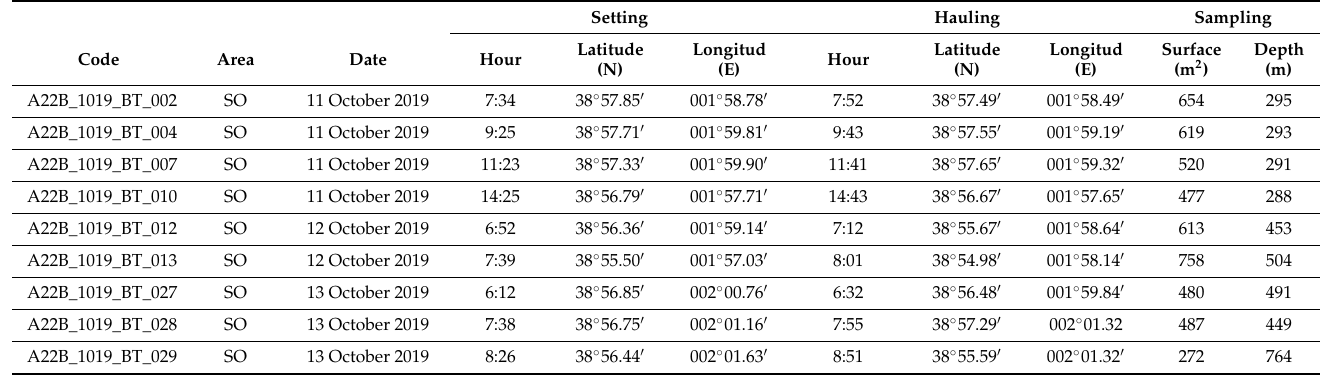
Table A3. Table characteristics of the sampling stations carried out with beam trawl in the Mal- lorca Channel seamounts Ses Olives (SO), Ausias March (AM), and Emile Baudot (EB) during the INTEMARES